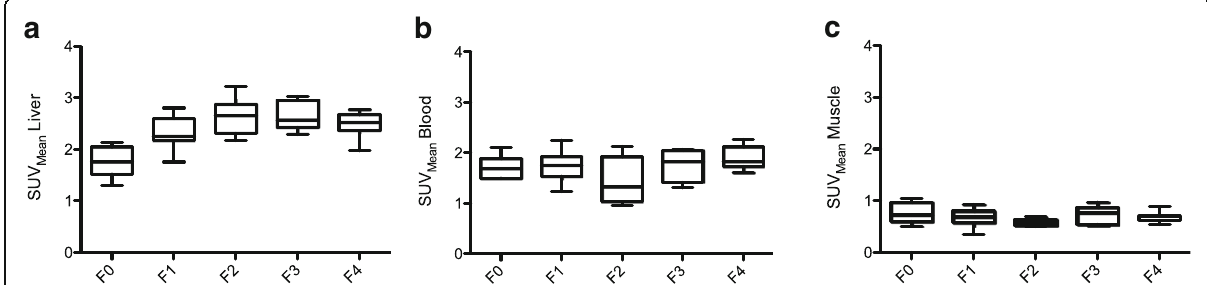
Fig. 1 The standardized uptake values (SUV) of the liver parenchyma ( a ), the aortic blood pool ( b ), and the skeletal muscle ( c ) in patients with normal liver parenchyma and patients with liver fibrosis/cirrhosis are shown. The Mann-Whitney U test was used to compare the following groups: no (F0), mild (F1), advanced (F2), severe liver fibrosis (F3), and liver cirrhosis